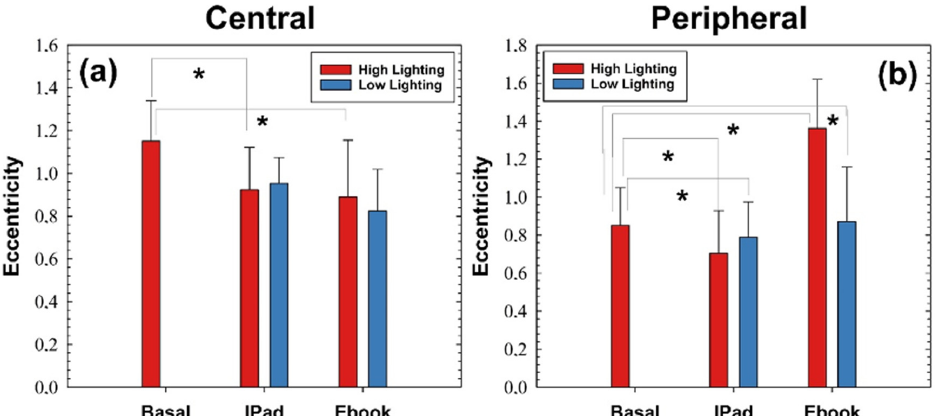
Figure 7. Mean and standard deviation (SD) of the central and peripheral retinal shape in high and low lighting conditions. Statistical differences ( p < 0.05) are marked with asterisks (*).